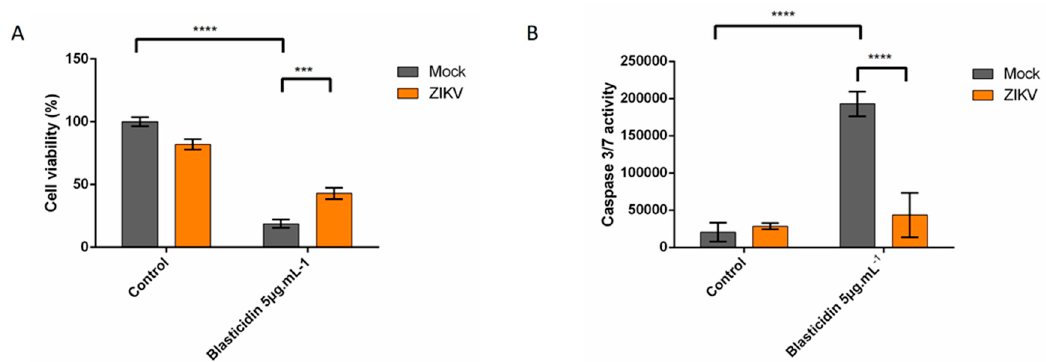
Figure 5. ZIKV provides a protection against intrinsically induced cell death by blasticidin. Vero cells were infected with ZIKV-PF13 at MOI of 1 for 8 h and treated with blasticidin for 16 h, followed by viability assay (MTT) ( A ) or caspase 3/7 activity ( B ). Values represent the mean and standard deviation of three independent experiments. Data were analyzed by a one-way ANOVA test with post-hoc Tukey’s test (** p < 0.01; *** p < 0.001, **** p < 0.0001, ns = not significant).